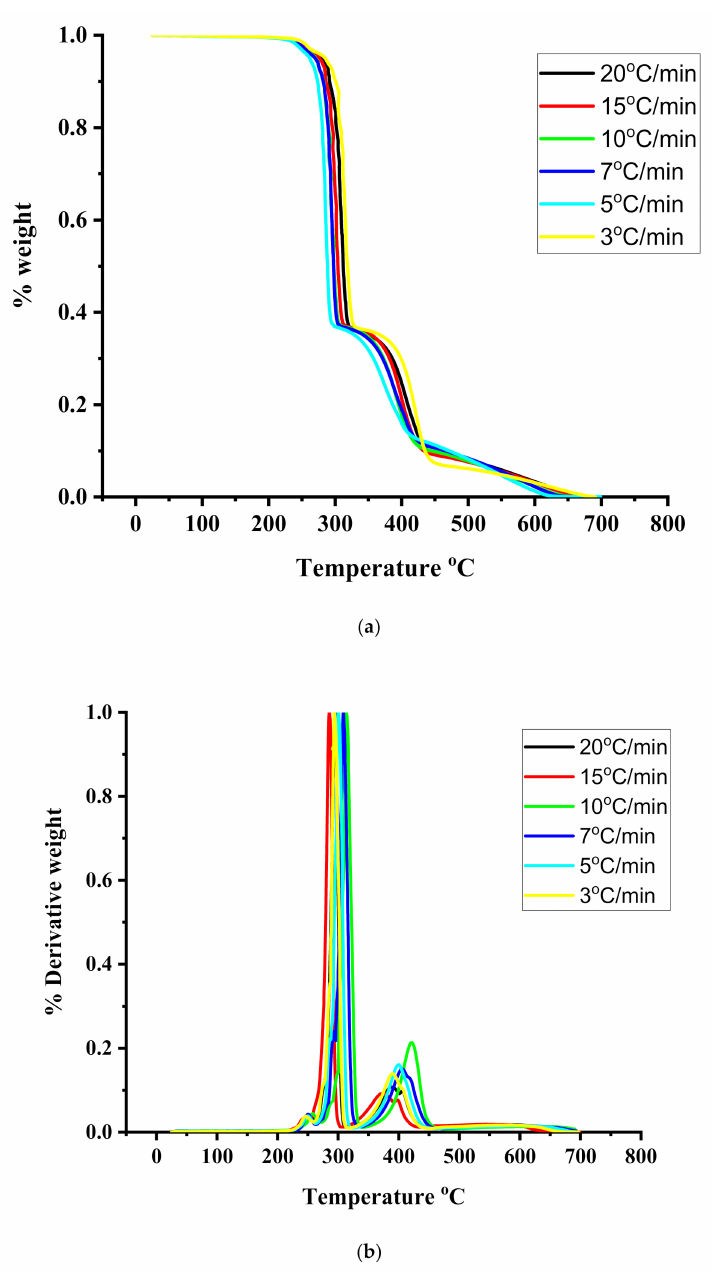
Figure 6. ( a ): TGA thermograms for the sample R40/60 under different heating rates. ( b ): DTG thermograms for the sample R40/60 under different heating